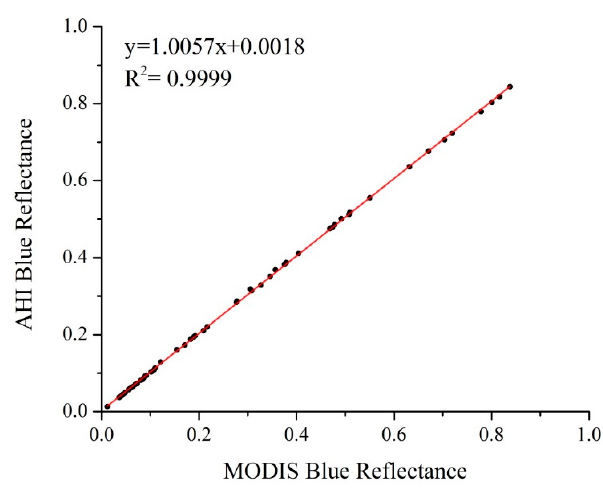
Figure 2. Scatterplot of different surface features.